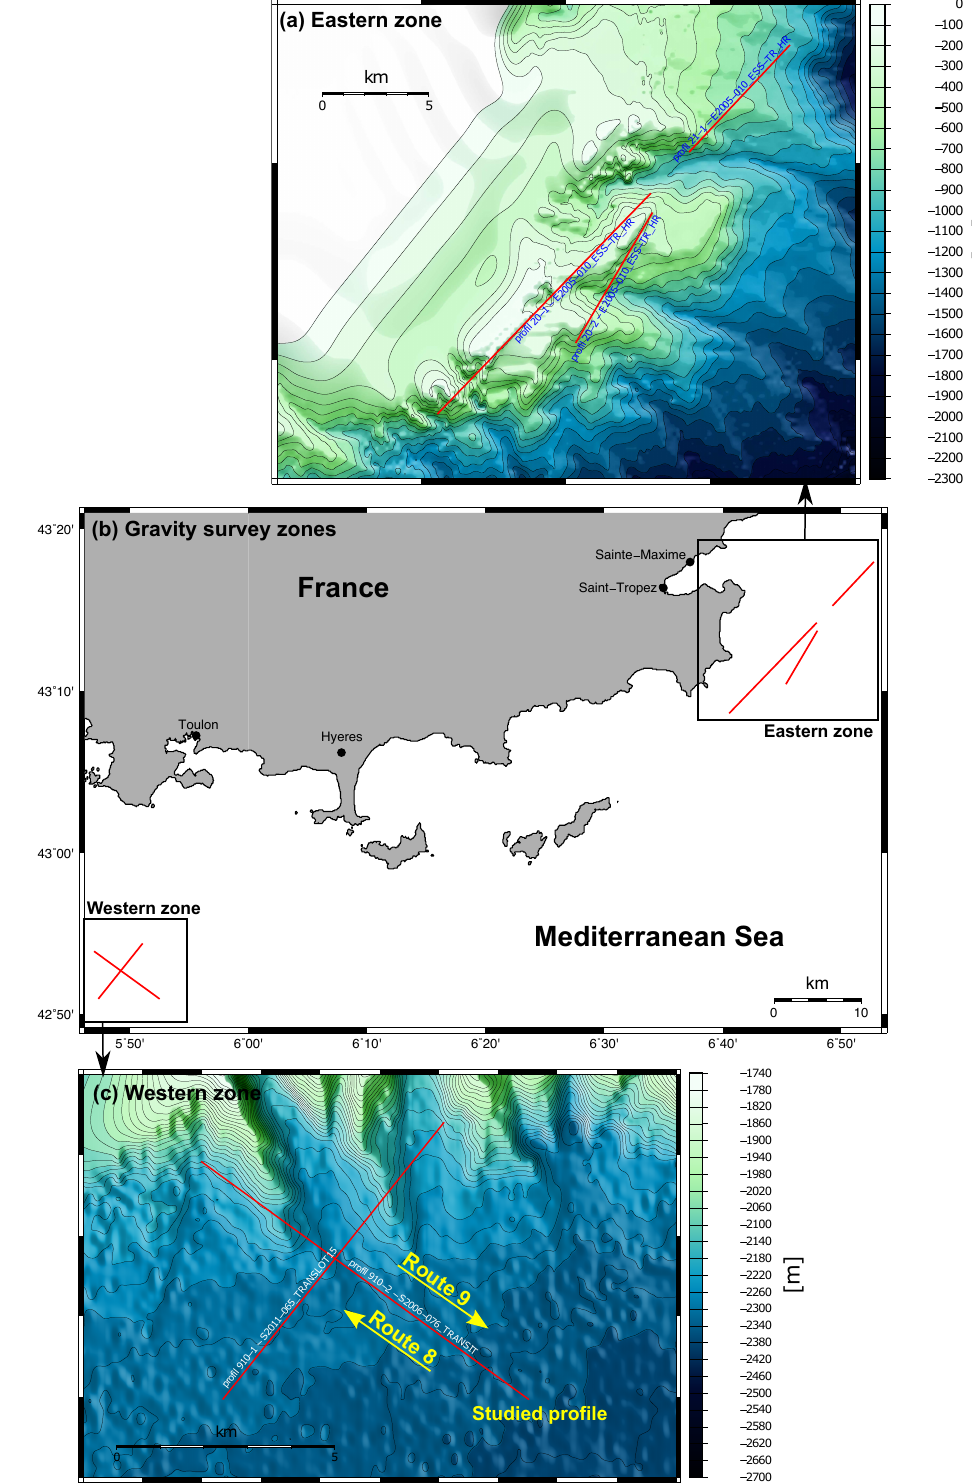
Figure 8. Gravity survey in the Mediterranean Sea carried out with the GraviMob system and the AUV Aster x . The location of the eastern and western zones is indicated by the black boxes on map ( b ). Each zone comprises two profiles along which the surface gravity was measured by the SHOM. The underwater relief in these two zones is depicted on the bathymetric maps ( a , c ). Map ( c ) indicates the studied profile on which our data processing was tested. The profile was crossed twice following routes 8 and 9 respectively. Maps were made using Generic Mapping Tools software